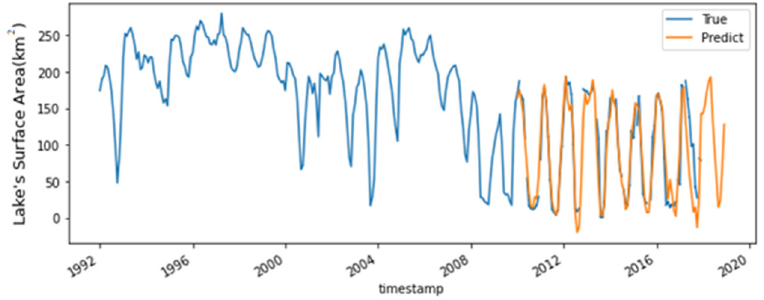
Figure 8. Prediction results of lake’s surface area based on MLP model II.